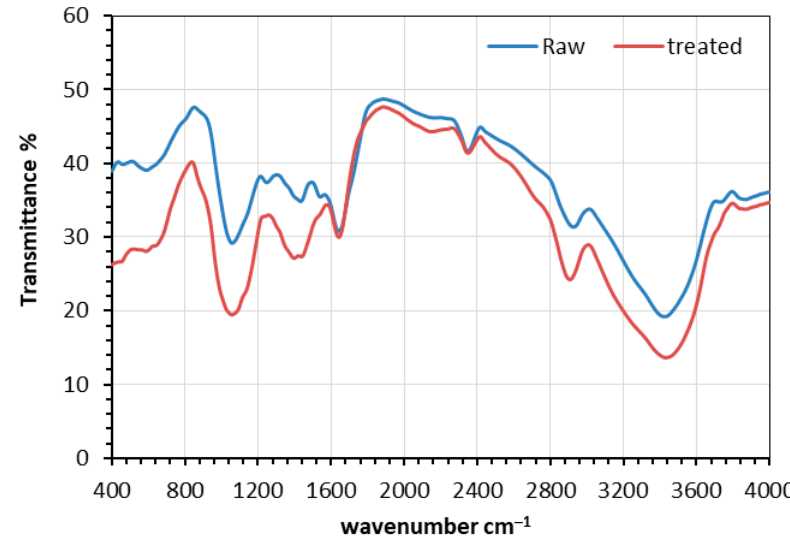
Figure 4. FTIR spectrum of raw and mechanically pretreated barley straw.